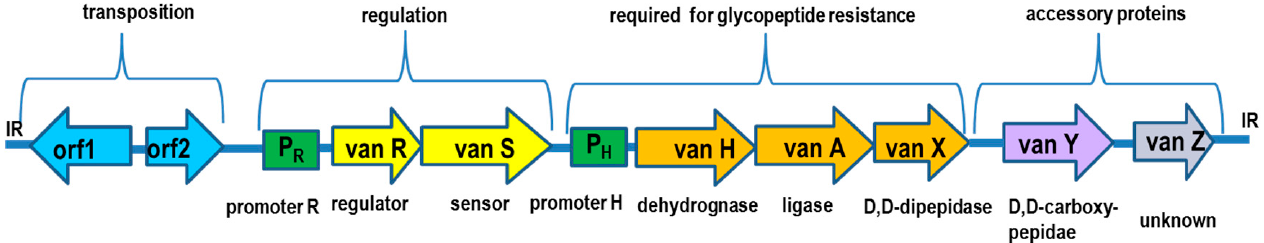
Figure 3. Van A operon. IR—inverted repeats, ORF—open reading frame .